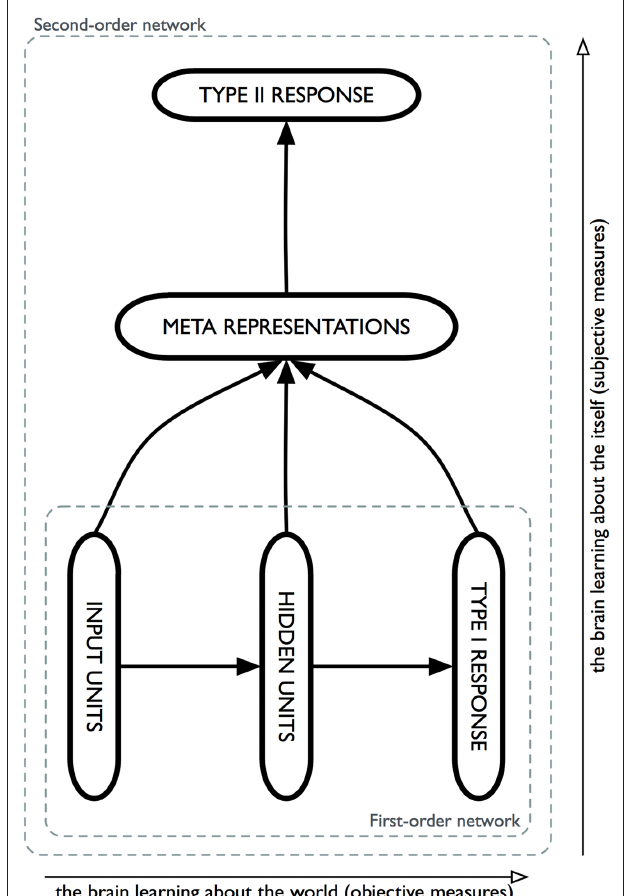
Figure 2 | Architecture of a wagering network. A first-order network instantiates a simple pattern classifier trained to classify “visual” input patterns representing the shapes of digits 0–9 in 10 categories. A second- order network is assigned the task of wagering on the first-order network’s performance based on the latter’s internal representations of the stimulus. The second-order network thus performs judgments about the extent to which the first-order network is correct in its